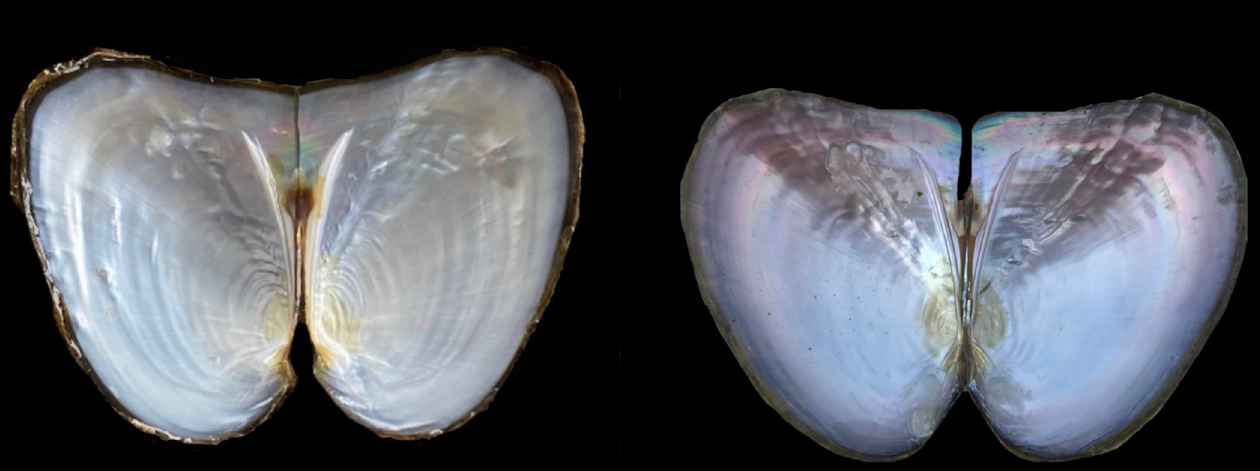
Fig 1. Mussels with white (left) and purple (right)